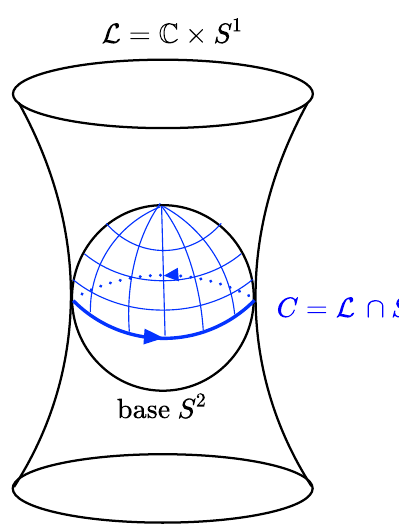
Figure 4 . The left figure shows a D-brane on L ⊂ Σ which intersects the base S 2 along the equator and extends in to the fiber directions along a hyperbola. In the right figure, we show the string loops in the time slice F Σ which lives in L . The state | HH i state is defined via worldsheets which end on these loops and wrap the upper hemisphere, as shown in the left figure. Similarly h HH ∗ | describes worldsheets on the southern hemisphere which end on